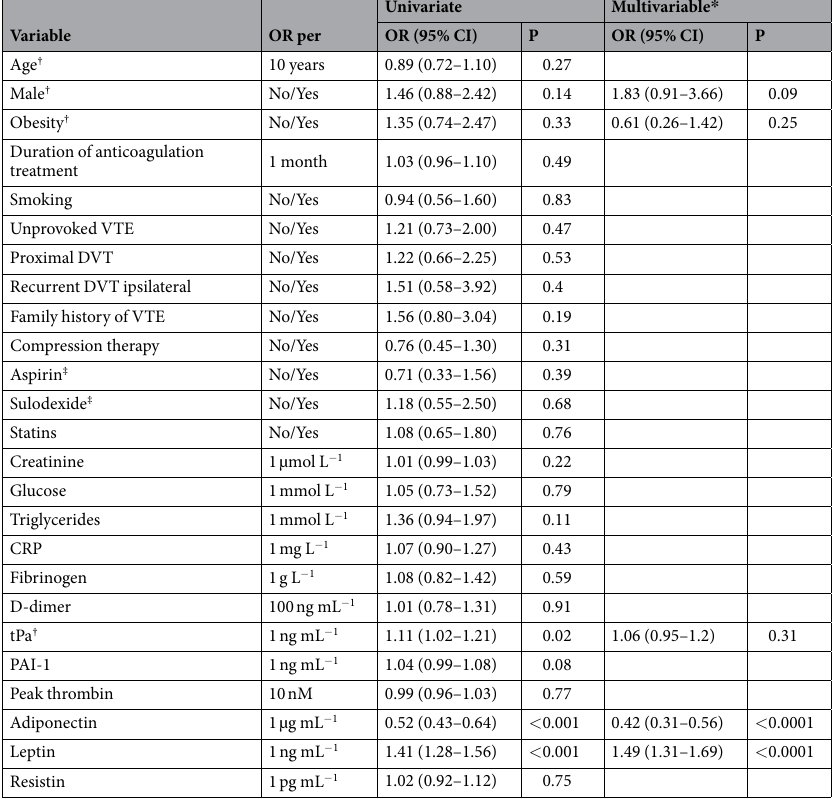
Table 2. The logistic Regression Model for Risk Factors of PTS. OR, odds ratio; CI, confidence intervals; other abbreviations see Table 1. * Multivariable model was fitted using backward stepwise regression. Adjusted for age. † Variable locked in the model. ‡ Medications initiated after anticoagulation withdrawal during follow-up.